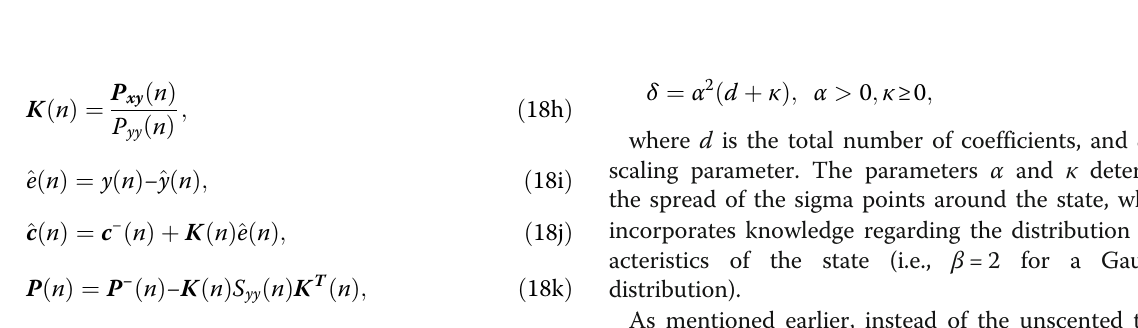
Fig. 1 Proposed procedure for estimating the nonlinearity f f ^ c ð n − 1 Þg in the case of the cascade TV-ARMA structure (Eq. 16a). y ( n ) is fed into the inverse filter 1 providing the a priori estimate ^ e ð n Þ . f f ^ c ð n − 1 Þg can thus be computed as f f ^ c ð n − 1 Þg ¼ y ð n Þ − ^ e ð n H ð z ; n Þ